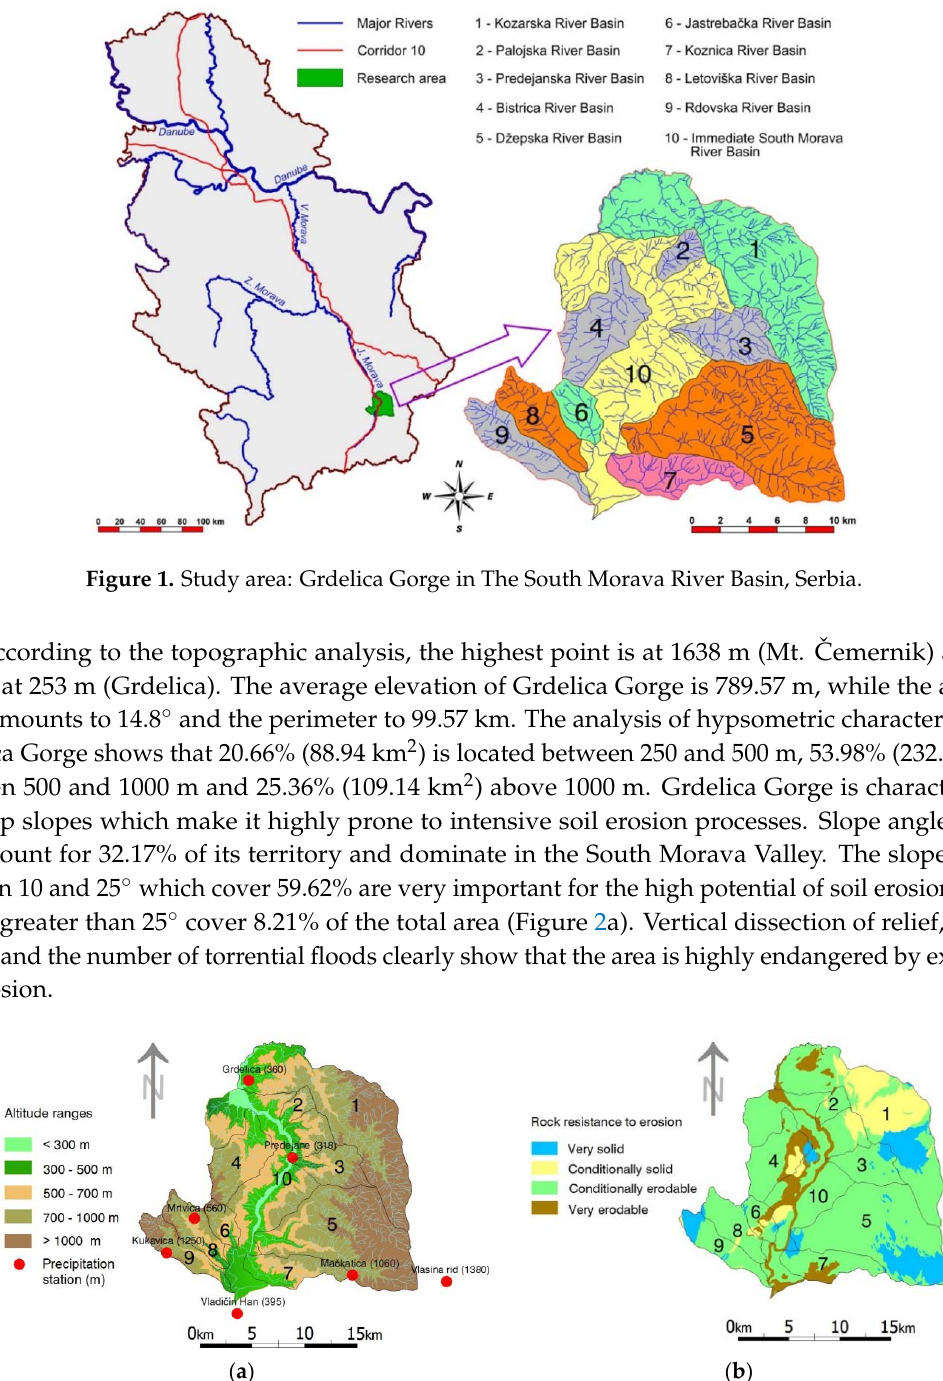
Figure 2. ( a ) Hypsometric map with the position of the precipitation stations; ( b ) Map of the rock resistance to erosion.